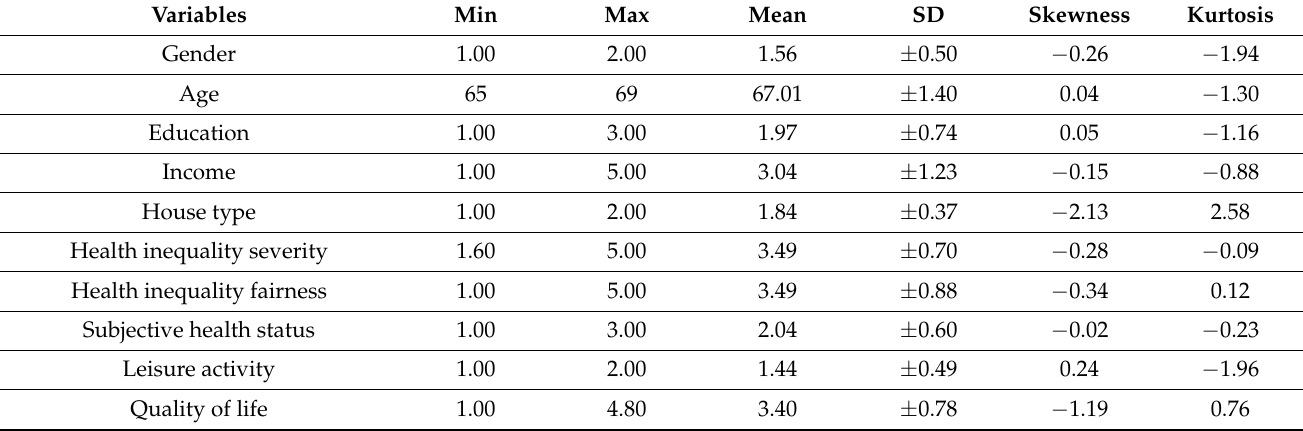
Table 4. Descriptive Statistics of